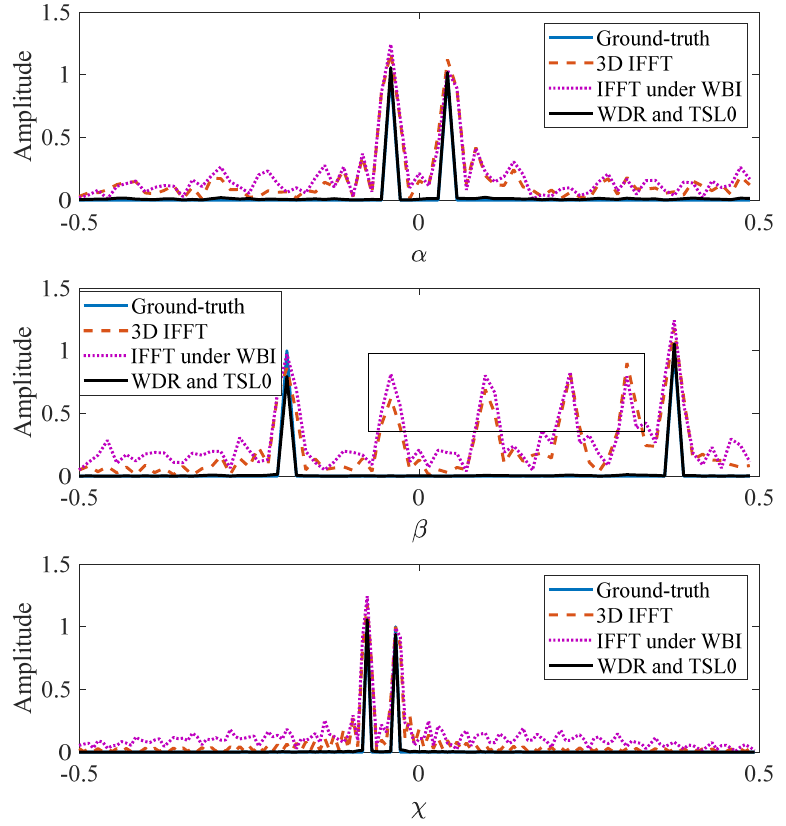
Figure 15. Comparisons of Figures 10, 11, and 14 for (top) β = 0.375 & χ = − 0.0764, (middle) α = − 0.0417 & χ = − 0.0764, and (bottom) α = − 0.0417 & β = 0.375. The black rectangle in the middle sub-figure indicates the sidelobes generated by other scattering centers.